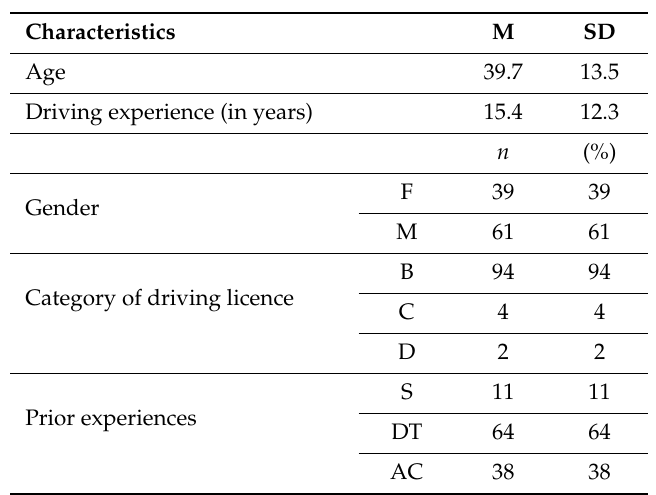
Table 1. Descriptive statistics of the study group (N = 100).